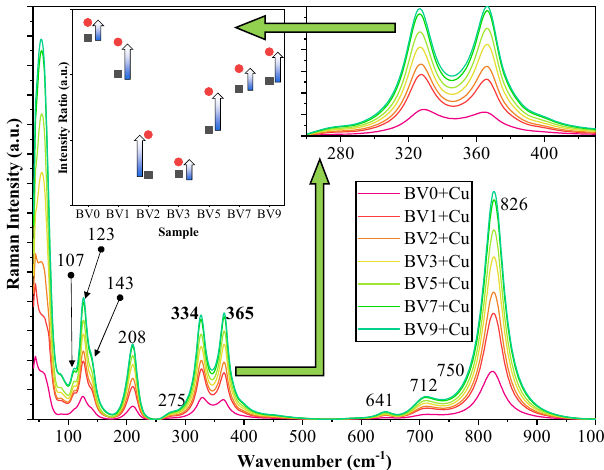
Figure 8. The Raman spectra of the Cu deposited BiVO 4 photocatalysts. The inset shows the changes of the bending mode assigned peaks, with the catalyst type.